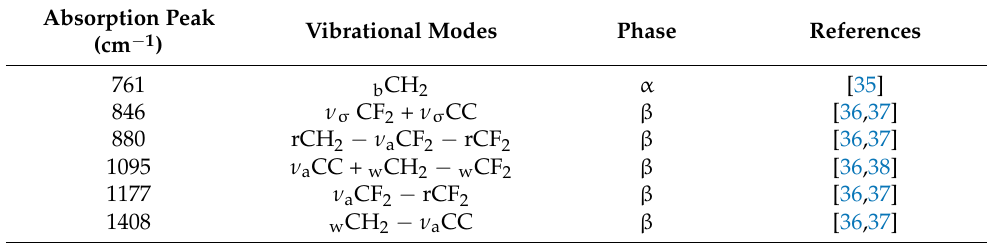
Table 2. Characteristics of P(VDF-TrFE) phase absorption peaks in the FT-IR spectra. Absorption